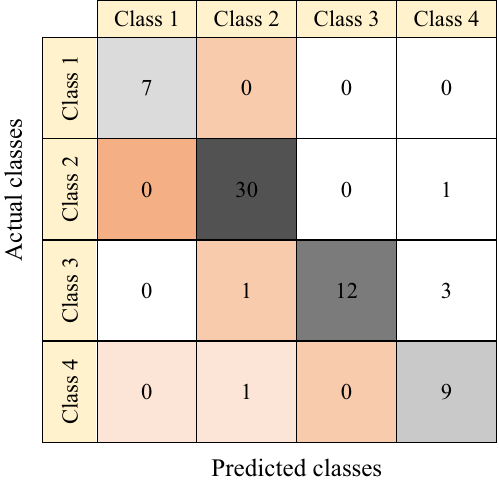
Fig. 18 Confusion matrix of logistic regression algorithm applied to data